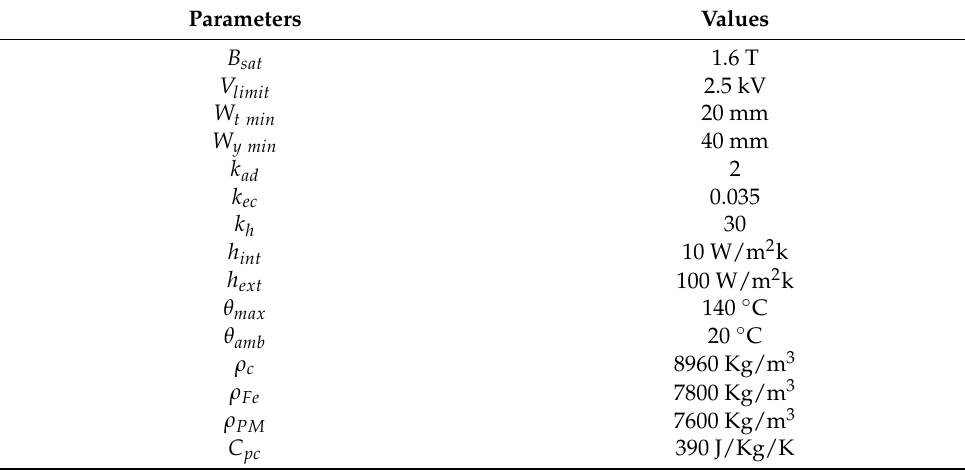
Figure 6. Speed-torque profiles for the generator. The main constant parameters used for the optimization are summarized in Table 2. The optimization parameters are listed in Table 3. Table 2. Constant parameters.